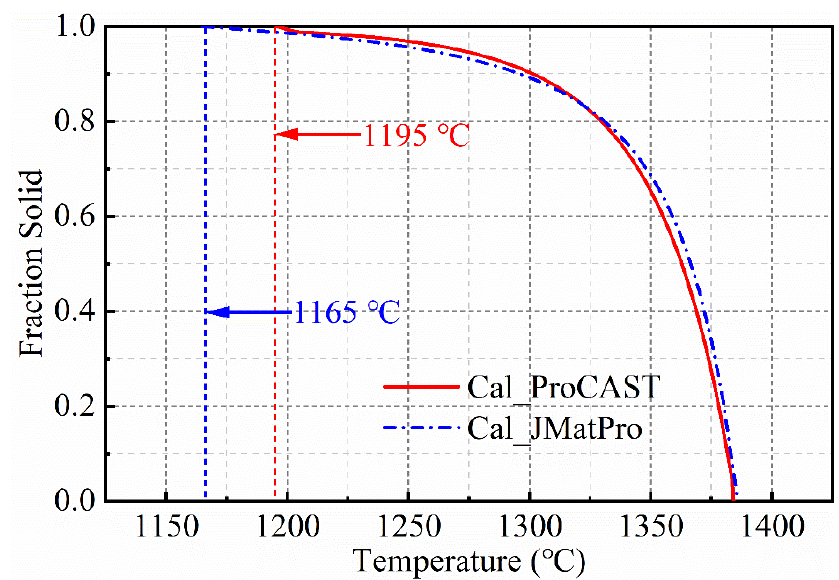
Figure 2. Fraction solid-temperature cure of SJTU-1 alloy calculated by ProCAST and JMatPro respectively.